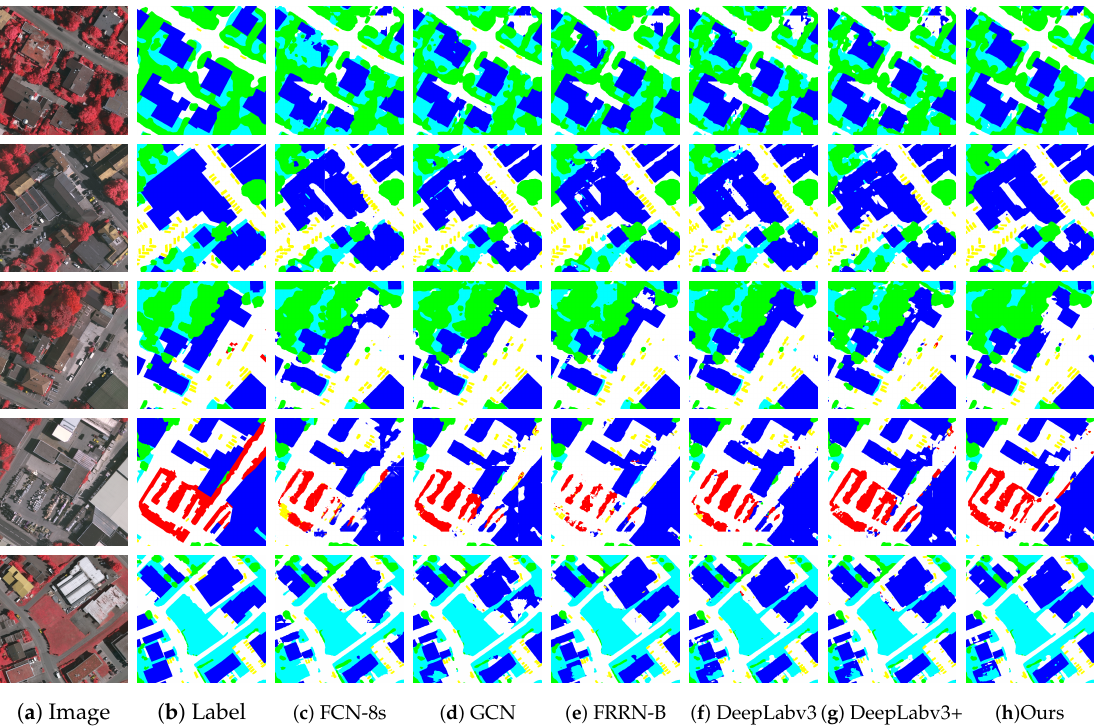
Figure 6. Visual comparisons with deep learning models of local evaluation on ISPRS Vaihingen dataset (white: impervious surface, blue: building roof, cyan: low vegetation, green: tree, yellow: car, red: